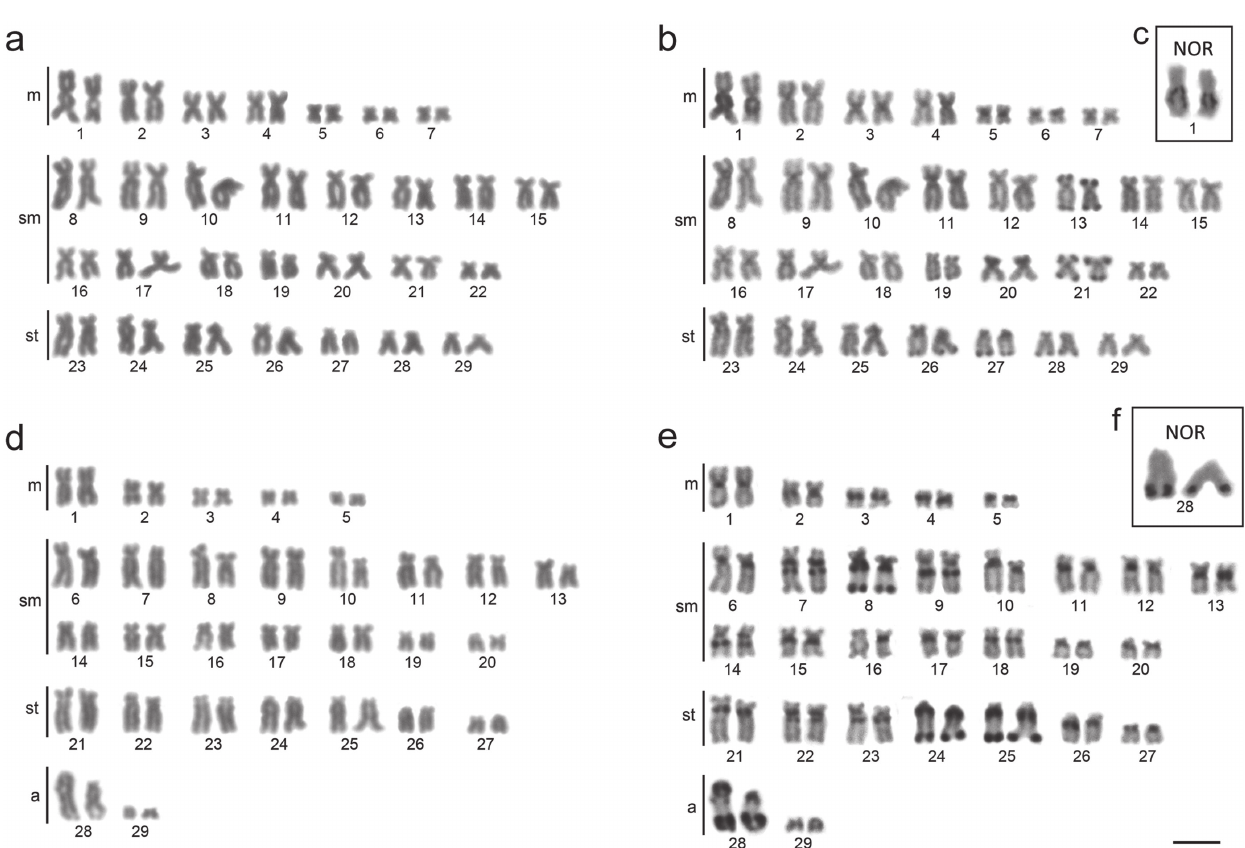
Fig. 1. Karyotype of Farlowella cf. amazonum : (a) Giemsa staining, (b) C-banding, and (c) NORs (highlighted). Karyotype of Farlowella schreitmuelleri : (d) Giemsa staining, (e) C-banding, and (f) NORs (highlighted). Scale bar = 10 µm.